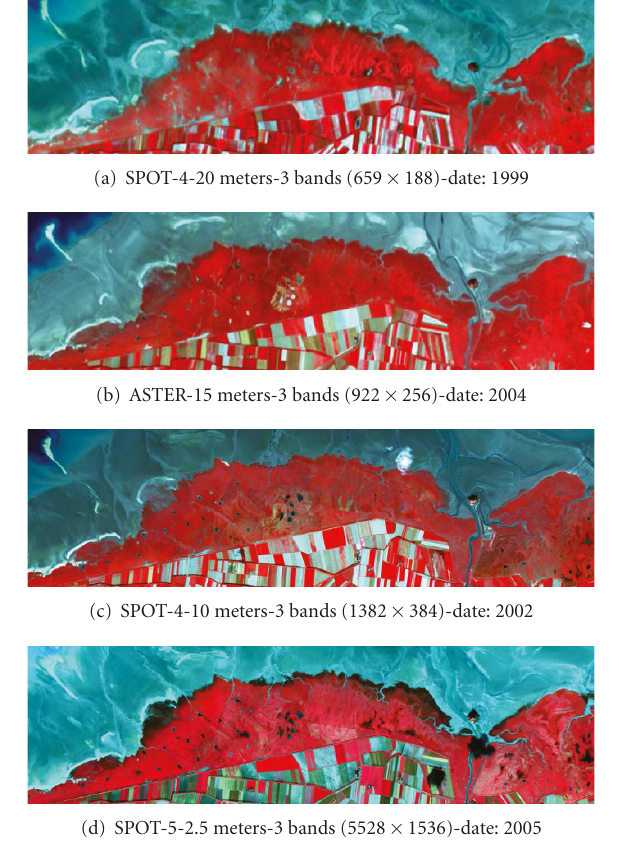
Figure 13: The four images of Normandy Coast, France.